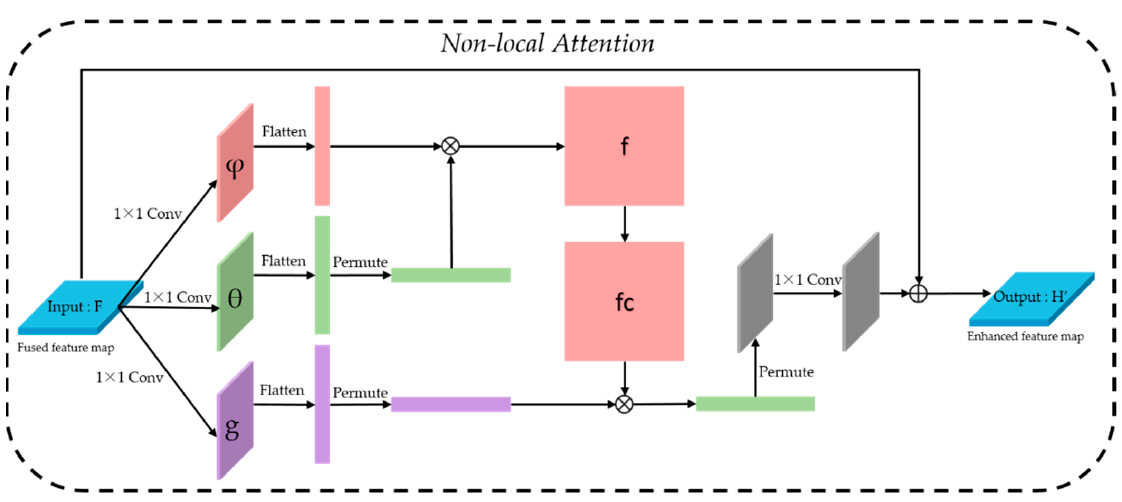
Figure 5. Architecture of non-local module.